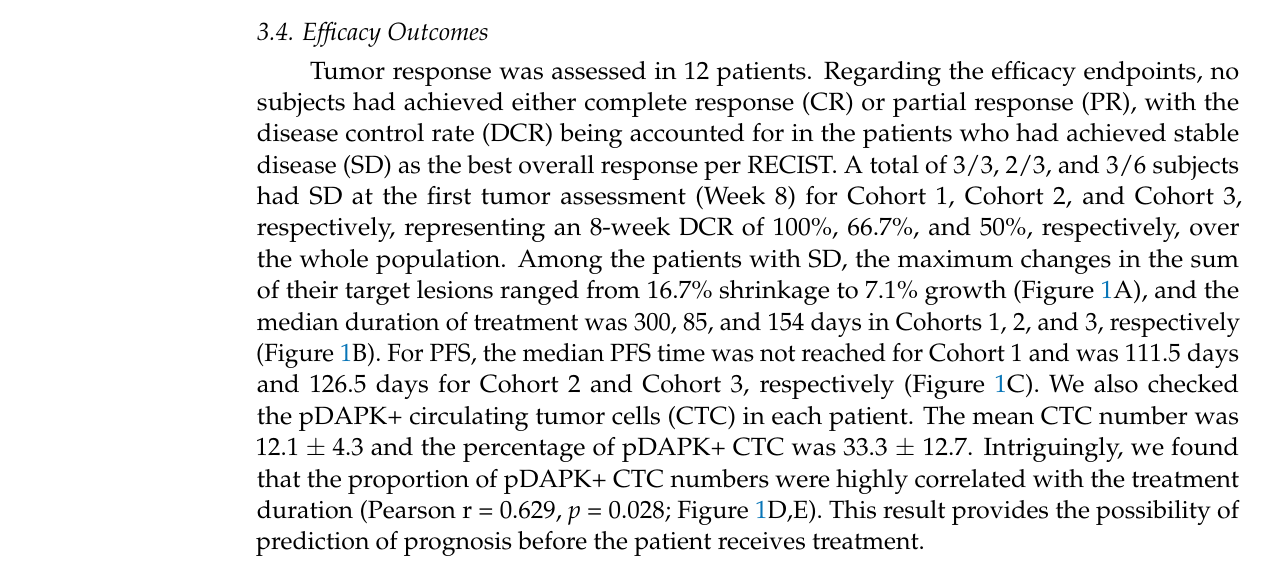
Figure 1. ( A ) Waterfall diagram showing changes in tumor size in target lesions in eight patients who achieved SD. ( B ) Treatment duration of each patient. ( C ) Overall survival of the patients. ( D ) Correlation of proportion of pDAPK + CTC numbers with treatment duration. ( E ) Immunofluores- cence staining of representative circulating tumor cells obtained from patients. Cancer cells fulfilled criteria for CTCs, including: CK − positive (green), CD45 − negative cells (non-red), and nucleated (blue). Scale bar = 5 μ m. 3.5. DAPK Expression in Primary vs. Metastatic Tumor The expression levels of pDAPK S308 were found to be higher when compared with their matched normal counterparts [9]. Moreover, our previous results showed that cell death induced by co-administration therapy in different cancer cells was positively corre- lated with pDAPK S308 levels [9]. To investigate the correlation between pDAPK S308 expres- sion levels and treatment efficiency, we used the IHC method with validated pDAPK S308 antibody as a qualitative analysis method. Our results demonstrated that the patients’ samples, which were positive for pDAPK S308 in IHC (Figure 2A), are correlated with their duration of treatment (260.6 ± 112.5 vs. 81.4 ± 55.6, p = 0.01; Figure 2B).